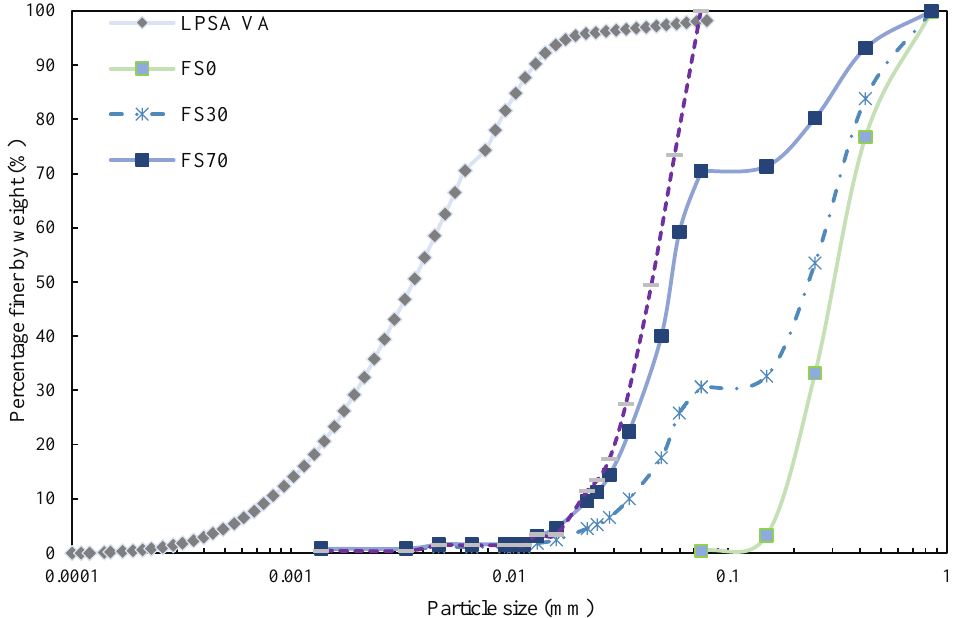
Figure 1. Particle size gradation curves of different soil samples (FS0, FS30, FS70, and FS100), and volcanic ash.